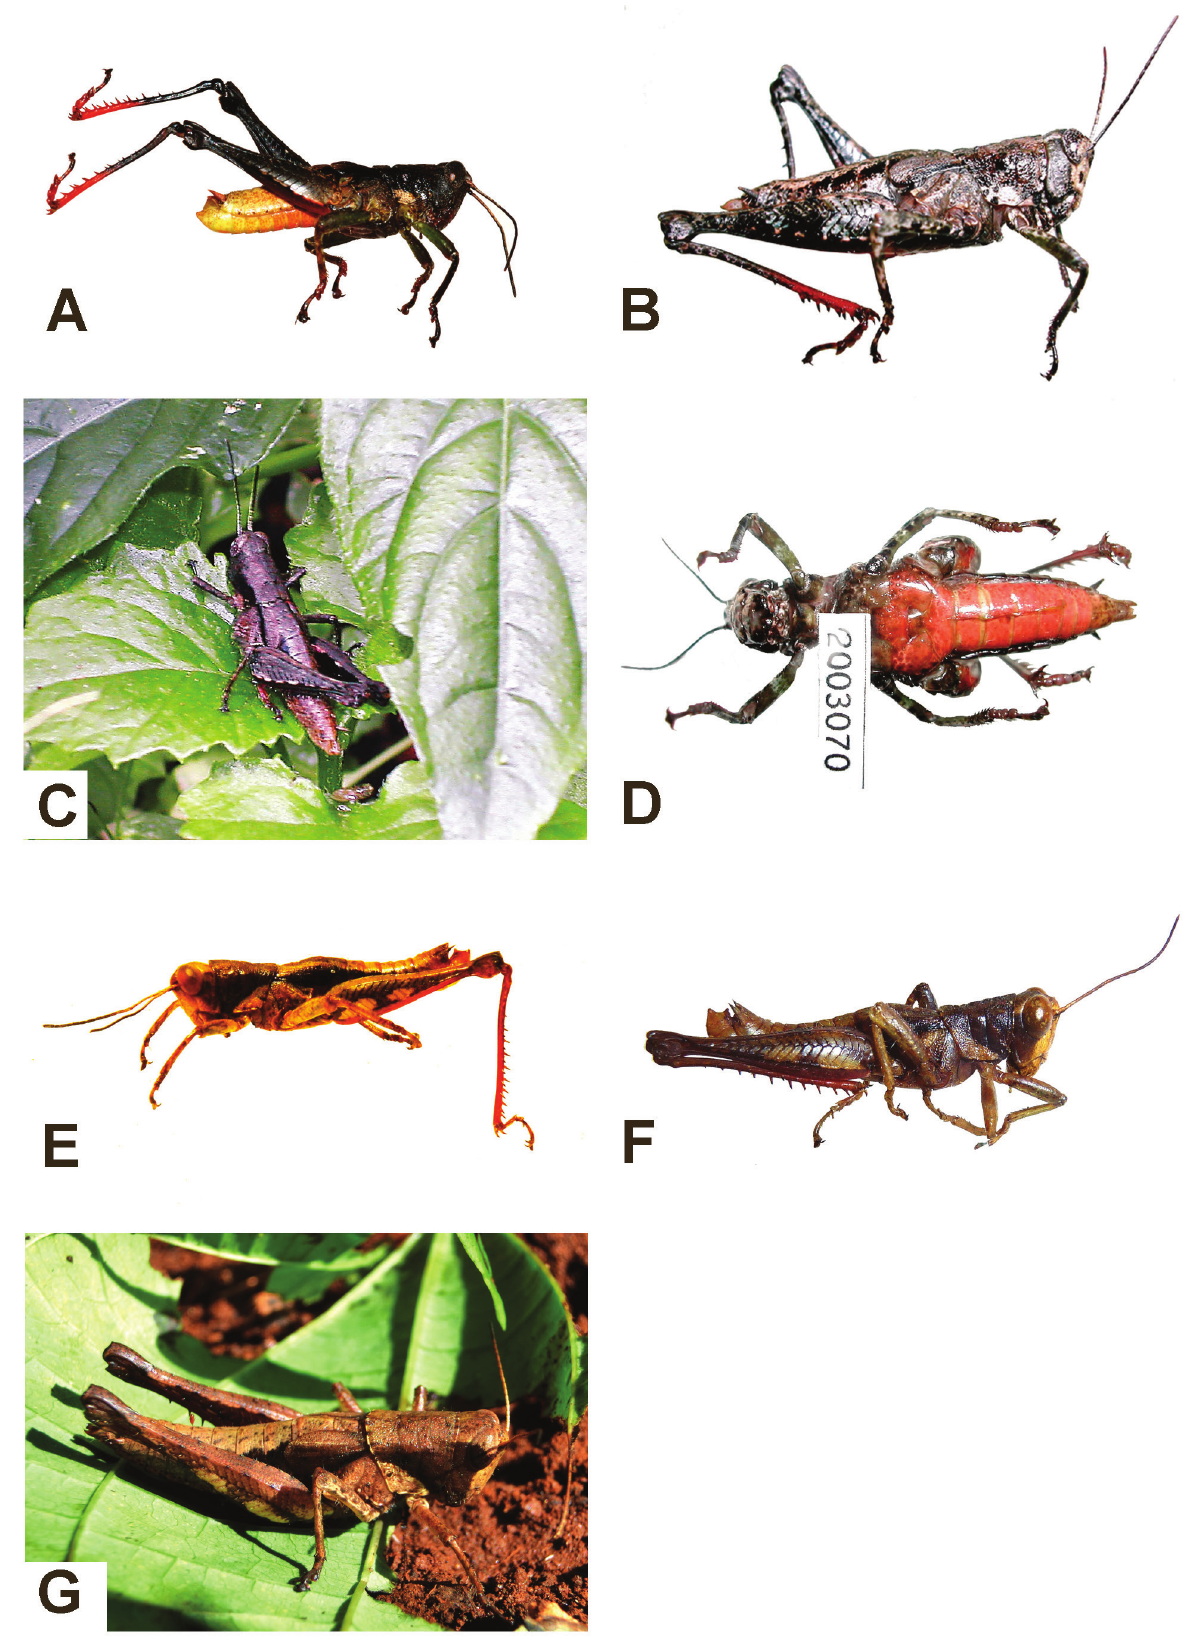
Fig. 1. A–D. Aresceutica lemarineli comb. n.: A. Male; B. Female, lateral; C. Female, dorsal, alive; D. Female, ventral view, to show char- acteristic red suffusion; E–G. Aresceutica nguruensis , sp. n.: E. Male holotype, lateral; F. Male paratype, lateral; G. Female paratype,